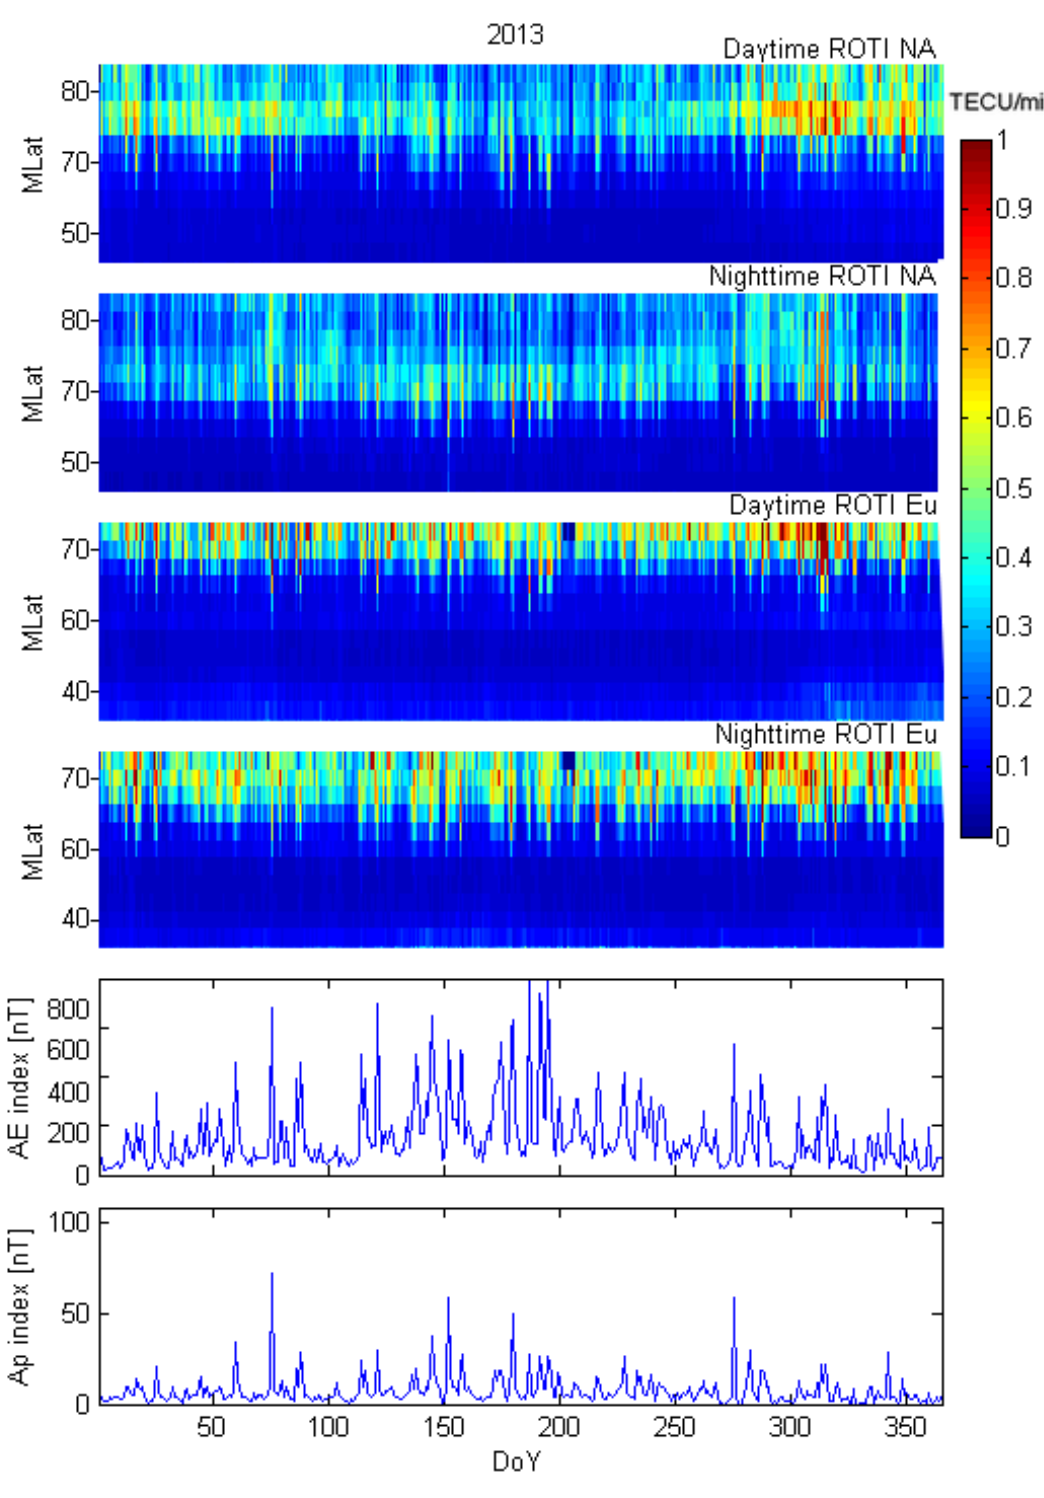
Figure 5. The long-term ROTI time-series in the North-American sector (panels 1 and 2 from the top—local daytime and nighttime series, respectively) and in the European sector (panels 3 and 4 from the top—daytime and nighttime series respectively), AE index time-series (panel 5 from the top), and Ap index time-series (the bottom panel)—for the year